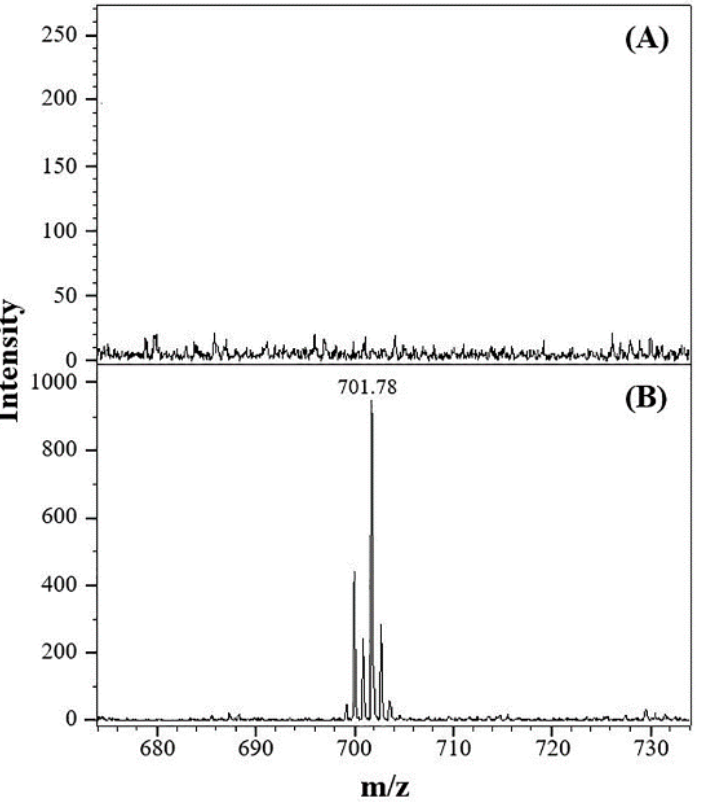
Figure 7. Mass spectra of human serum samples. ( A ) Posaconazole-spiked serum without EME and ( B ) posaconazole-spiked serum with EME. The ion signal at m/z = 701.78 corresponds to the protonated molecular ion of posaconazole. Experimental conditions: sample volume, 8 mL; applied voltage, 80 V; stirring rate, 100 rpm; extraction time, 15 min; and posaconazole, 0.80 μM. All other conditions were identical to those outlined in Figure 2.